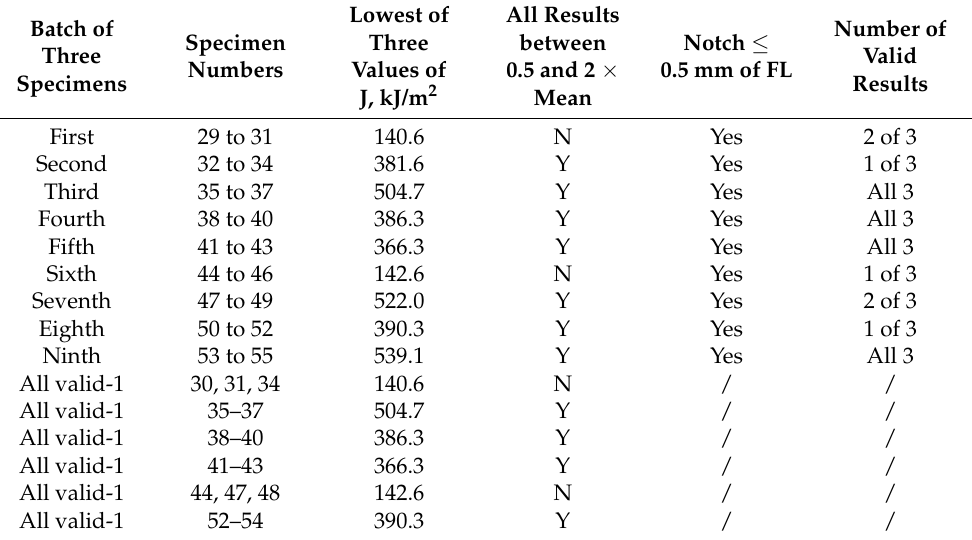
Table 6. Examples of results from separate batches of three specimens, taken from the full dataset, and from the subset of valid results.